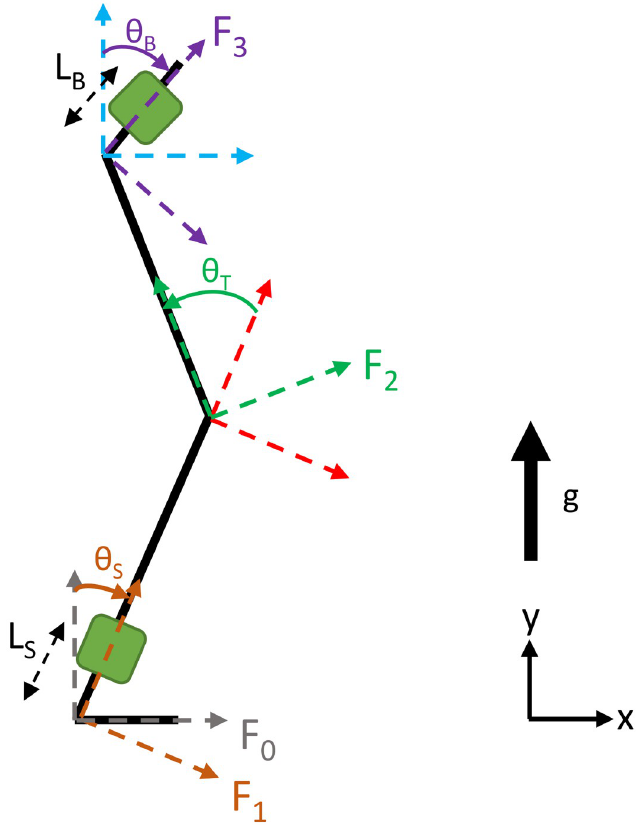
Fig 1. Leg and trunk three-segment 2-dimensional model in the sagittal plane. θ S is the angle for the shank, θ T is the angle for the thigh and θ is the angle for the back. Green squares on the shank and back segment represent the inertial B sensors. L and L denote the distance of the sensor placement on the shank from the ankle and the back from the hip S B respectively. placed at a distance L from the ankle on the shank and at a distance L from the hip on the S B back. Angular kinematics including position θ , velocity ω and acceleration α , i 2 { S , T , B } i i i for each of the three segments were to be determined. The θ , ω and α are functions of time i i i where θ , θ 2 [0, π /2) and θ 2 [ − π /2, π /2). S T B For estimation of the shank and back angular kinematics, the translation of the ankle and hip joints is neglected and the same model is applied to both the segments. Such approxima- tion is straightforward for the ankle as the foot is on the ground during sit-to-stand transitions and the shank pivots around the ankle; it is also reasonable for the hip and necessary for the kinematic estimation from only one sensor. Vectors are written in bold; the superscript of the vector refers to the coordinate frame in which it is written, for e.g. 0 g ; if omitted, the vector is written in the reference frame {0}; matrices are written in capital letters. Rotation matrices from frame j to frame k are written as j R . k in the reference frame. The linear acceleration a 2 R 3 ; i 2 f S ; B g of the sensor, written in the i reference frame is given by Eq (1) [35], where ω 2 R 3 is the angular velocity and _ ω 2 R 3 is i i the angular acceleration.